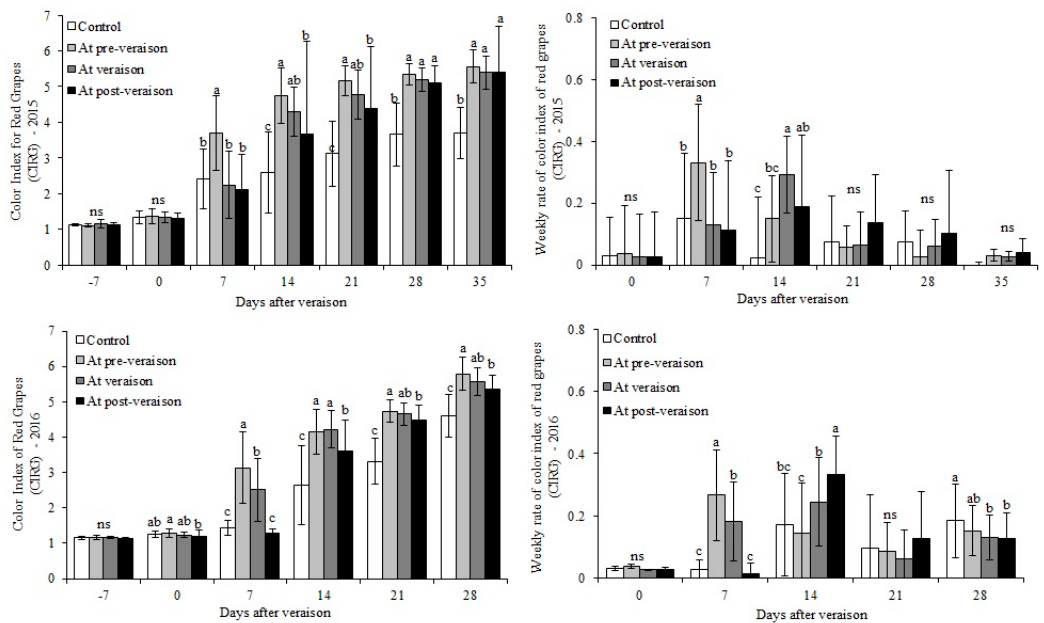
Figure 2. Color index of red grapes (CIRG) and weekly rate of color index for red grape (CIRG) of ‘Benitaka’ berries ( Vitis vinifera L.) subjected to ( S )- cis -abscisic acid ( S -ABA 400 mg L − 1 ) at different timings of ripening. A second application of S -ABA 400 mg L − 1 was performed for all treatments 10 days after the first application, except for the control. Means within columns for the same letter followed by different letters differ significantly by Tukey’s test ( p < 0.05). ns: non-significant. Agronomy 2019 , 10 , x FOR PEER REVIEW